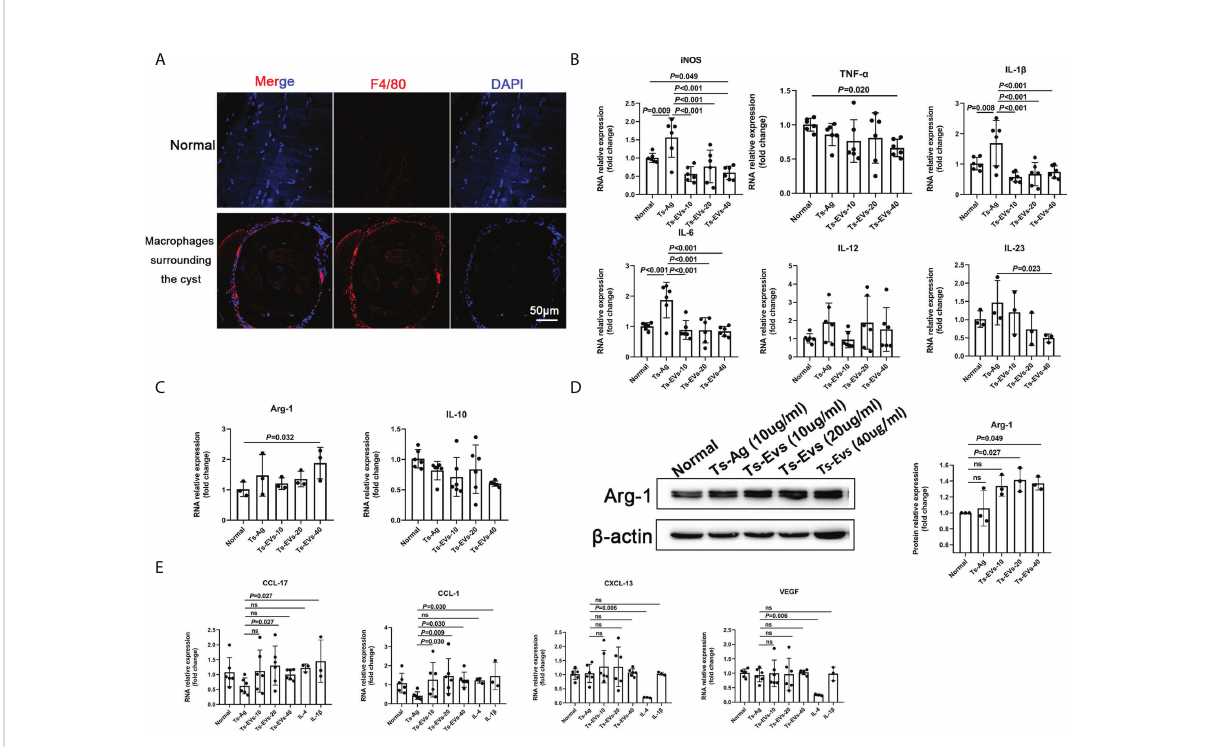
FIGURE 2 EVs (10, 20, 40 µg/mL) secreted by T. spiralis and T. spiralis soluble antigens (10 µg/mL) were used to stimulate mouse bone marrow-derived macrophages (BMDMs), and real-time fl uorescent quantitative PCR (qRT-PCR) and western blotting were used to detect the levels of related in fl ammatory cytokines. (A) Macrophages surrounding the cyst of larvae were labeled with F4/80 antigen and observed using immuno fl uorescence. (B) The M1-type macrophage marker factors were analyzed using RT-PCR. (C) The M2-type macrophage marker factors were analyzed using RT-PCR. (D) Arg-1 was analyzed using western blotting. (E) The M2-type macrophage subtype marker factors were analyzed using qRT-PCR, IL-4 (M2a), and IL-1 b as positive controls (M2b). ns, no signi fi